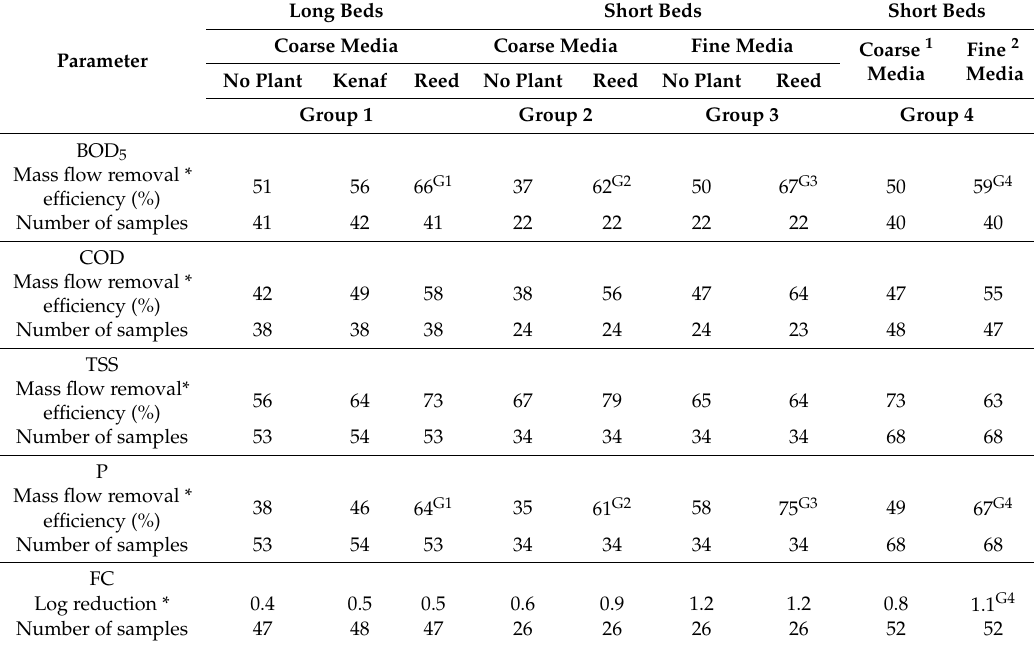
Table 2. BOD 5 , COD, TSS, Fecal Coliform, and P